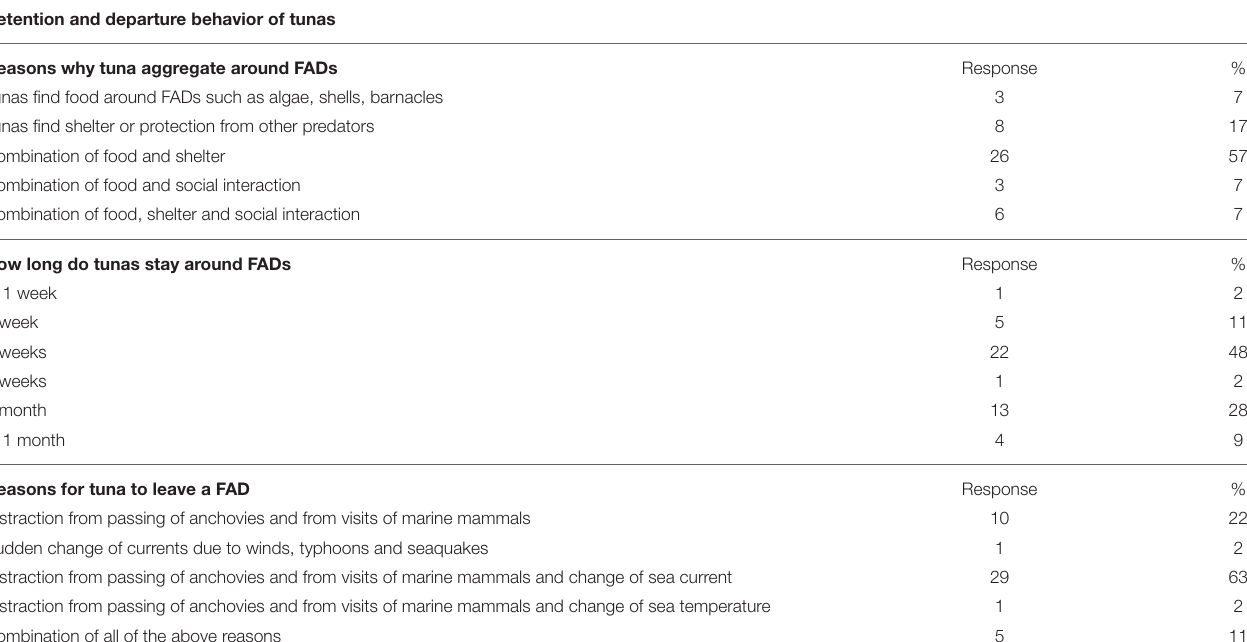
TABLE 2 | Fishers’ responses related to retention and departure behavior of fish to anchored FADs.